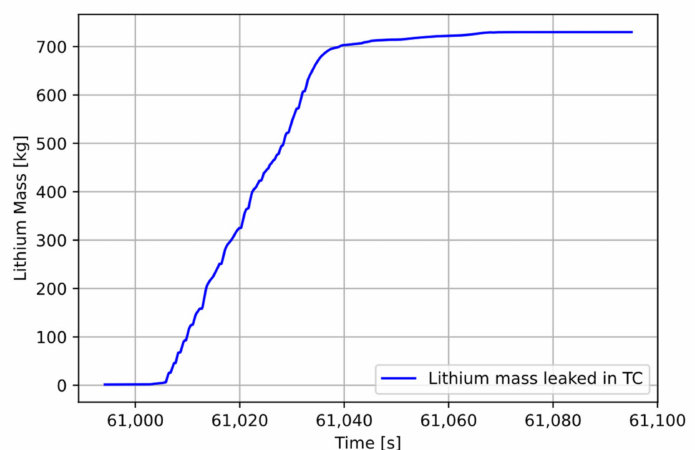
Figure 7. Inventory in QT(CVH850) and released in TC